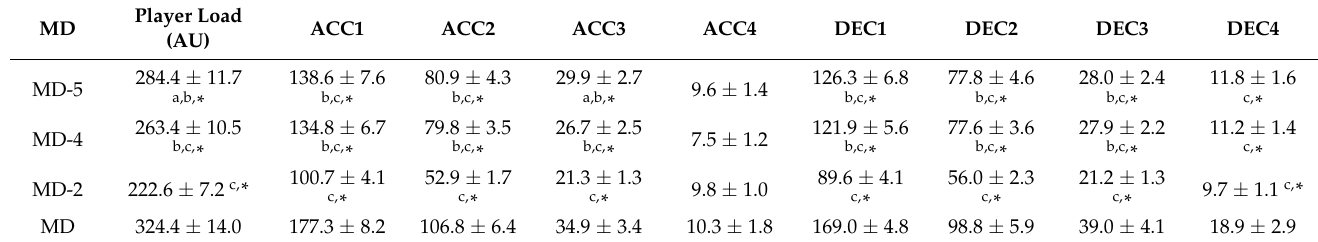
Table 2. External Intensity by accelerometery-based variables during training and matches for squad average (mean ± SD).